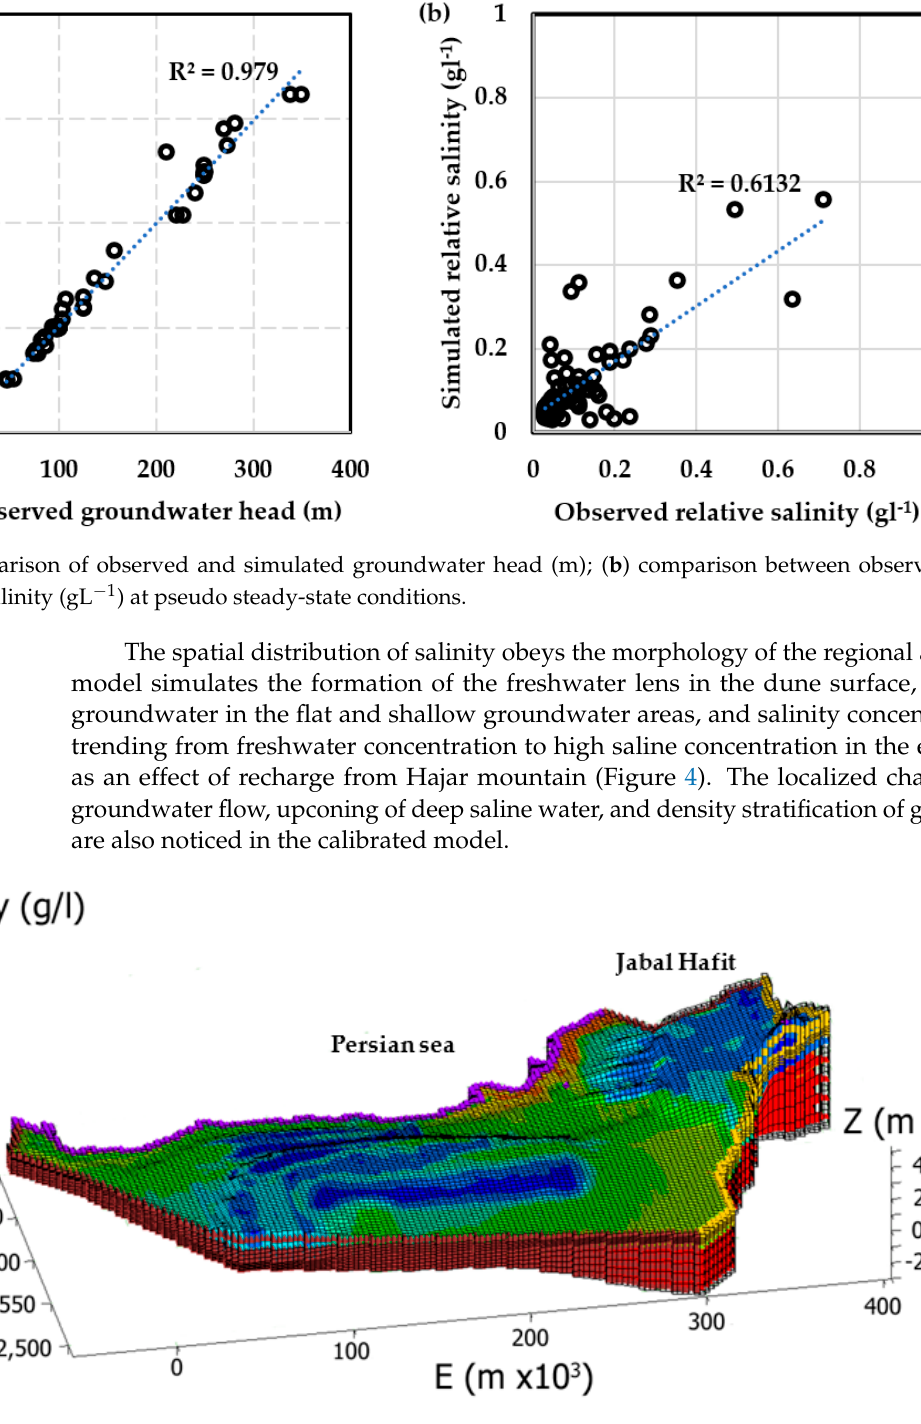
Figure 4. Spatial salinity of the calibrated model under quasi steady state condition.